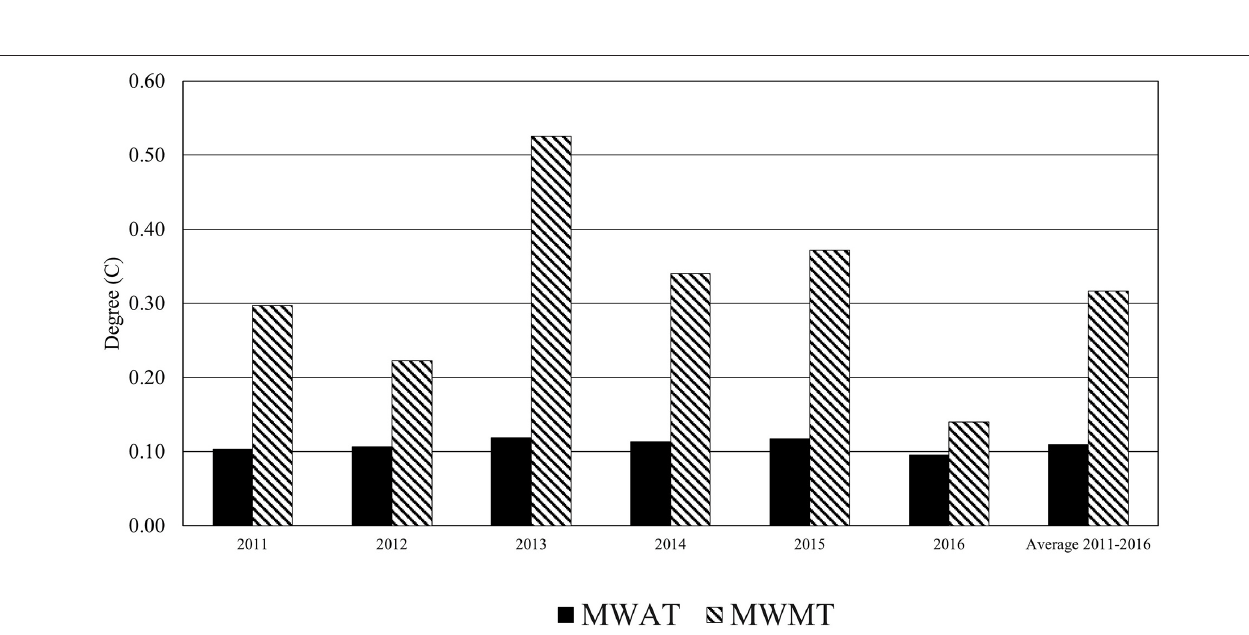
FIGURE 9 | Average MWAT and MWMT temperature ( ◦ C) differences between each canopy reduction scenario when all stream segments were reduced and initial, second and third-growth conditions.